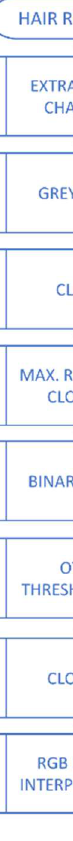
Figure 3. Hair removal (CLAHE stands for contrast limited adaptive histogram equalization).